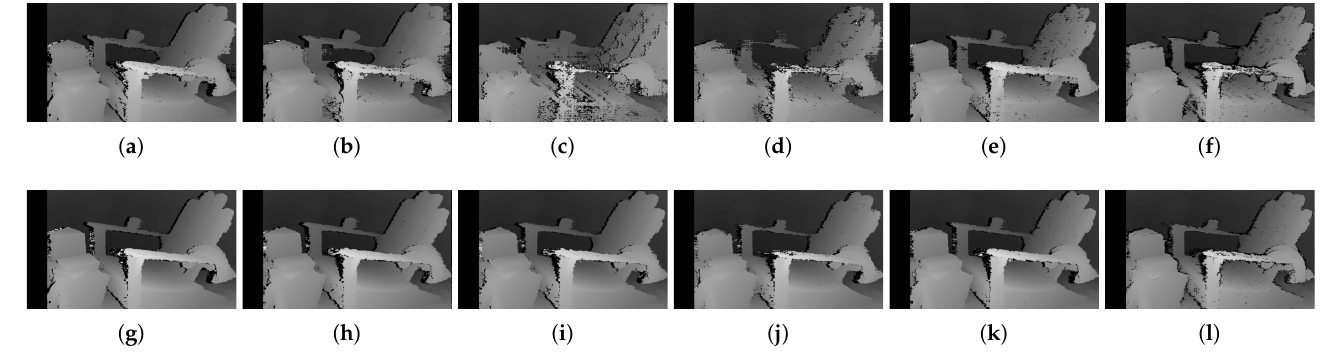
Figure 10. Estimated disparity images of the combinations of cost and image filter using the SGM stereo method according to the low and high pattern intensity parameters. The images in the top row show disparities at the low intensity parameter, and the images in the bottom row show those at the high intensity parameter, respectively. ( a ) SGM, AD. ( b ) SGM, Mean/AD. ( c ) SGM, LoG/AD. ( d ) SGM, BilSub/AD. ( e ) SGM, Rank/AD. ( f ) SGM, Census. ( g ) SGM, AD. ( h ) SGM, Mean/AD.